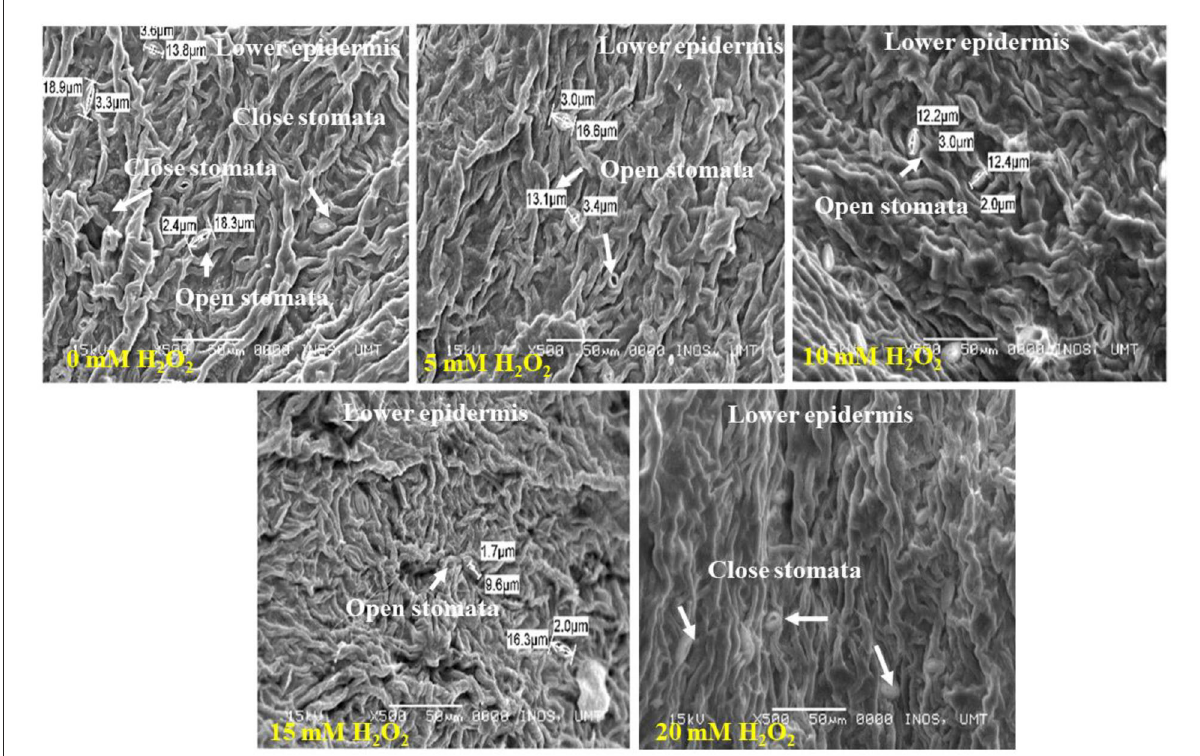
FIGURE4 SEM photographs of stomatal closure at lower surface of the F. deltoidea leaves. Lower leaf surface contained a higher number of stomata than the upper surface. The smallest stoma size was observed in the 15mM H 2 O 2 treatment and stoma size started to decrease with an H 2 O 2 concentration increase under drought